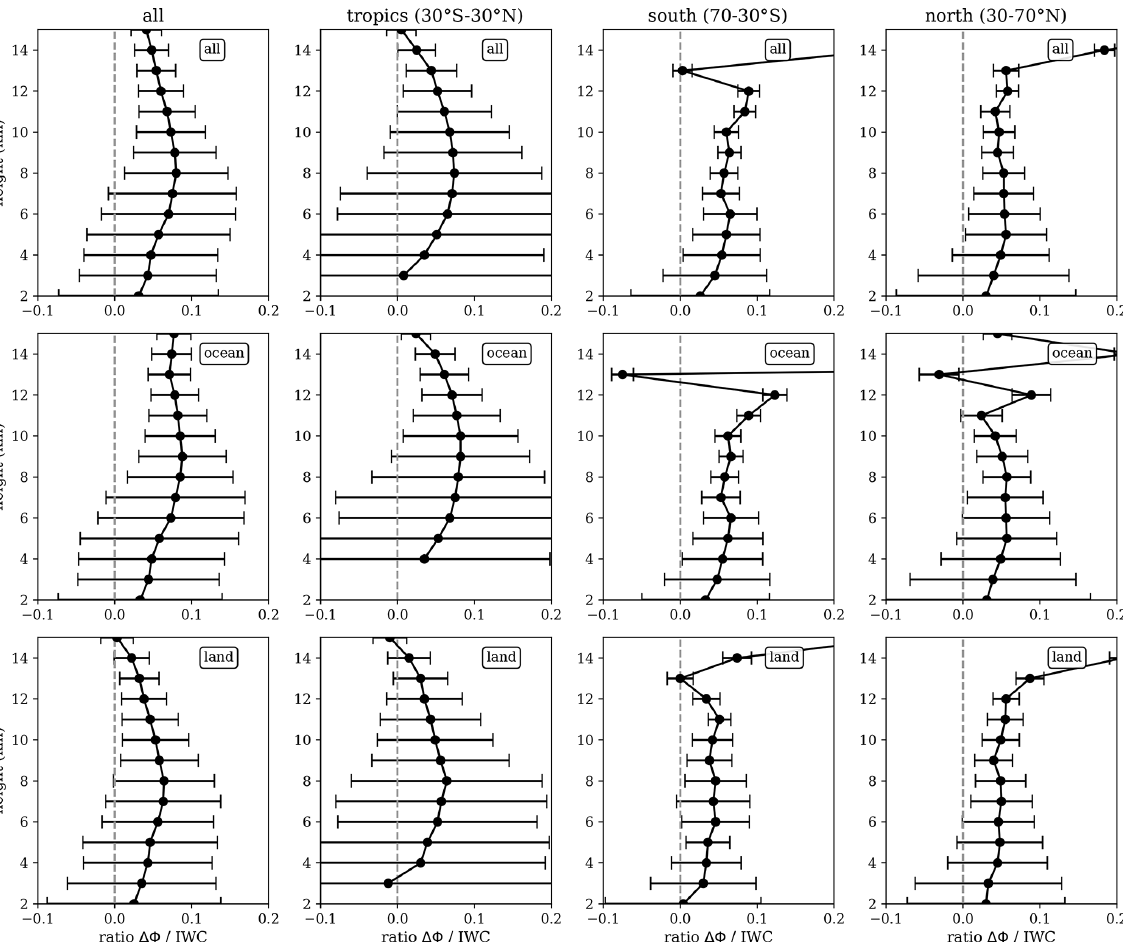
Figure 7. Ratio between PAZ (cid:49)(cid:56) mean climatology and CloudSat-RO-integrated IWC mean climatology, as a function of height ( y axis), for different areas across the globe (all globe, tropics, southern extratropics, and northern extratropics), and different surfaces (all, ocean, and land). The x axis error bars show the root mean squared error around the fit from which we obtain the ratio (e.g., see Fig.